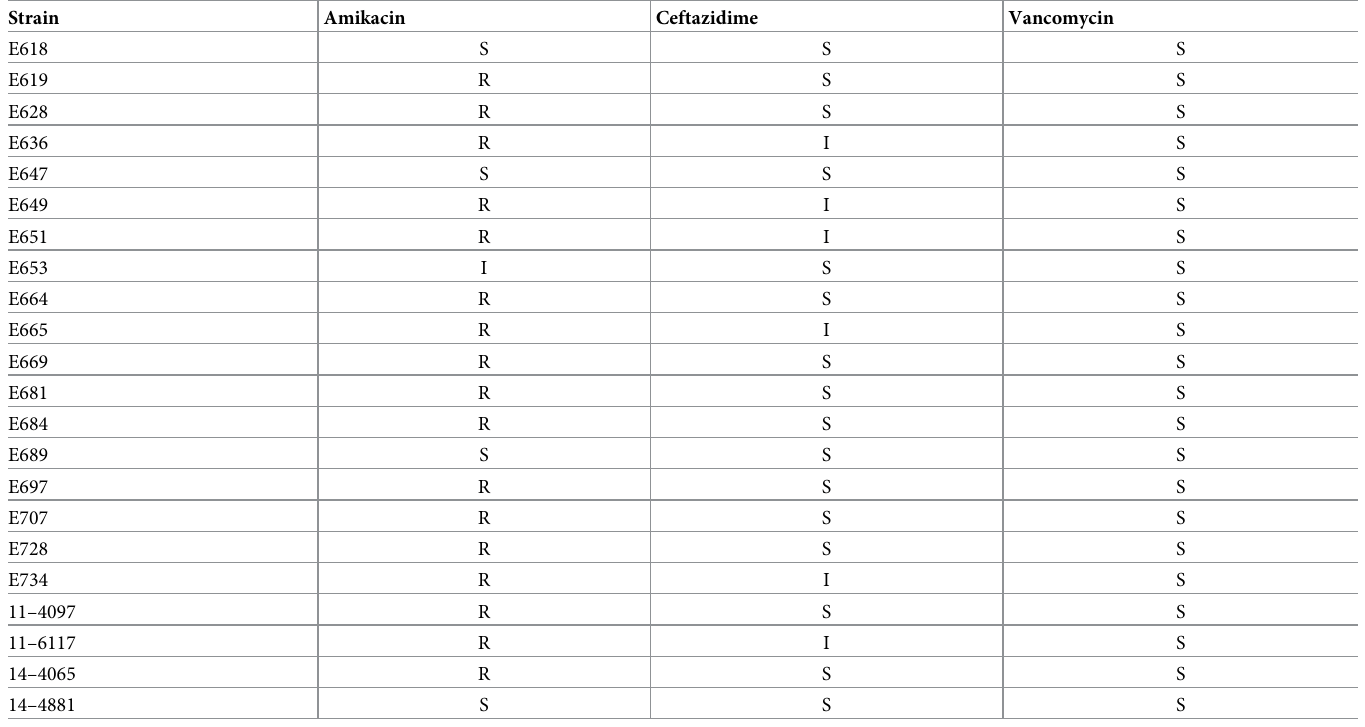
Table 2. Antibiotic susceptibilities of clinical endophthalmitis strains.